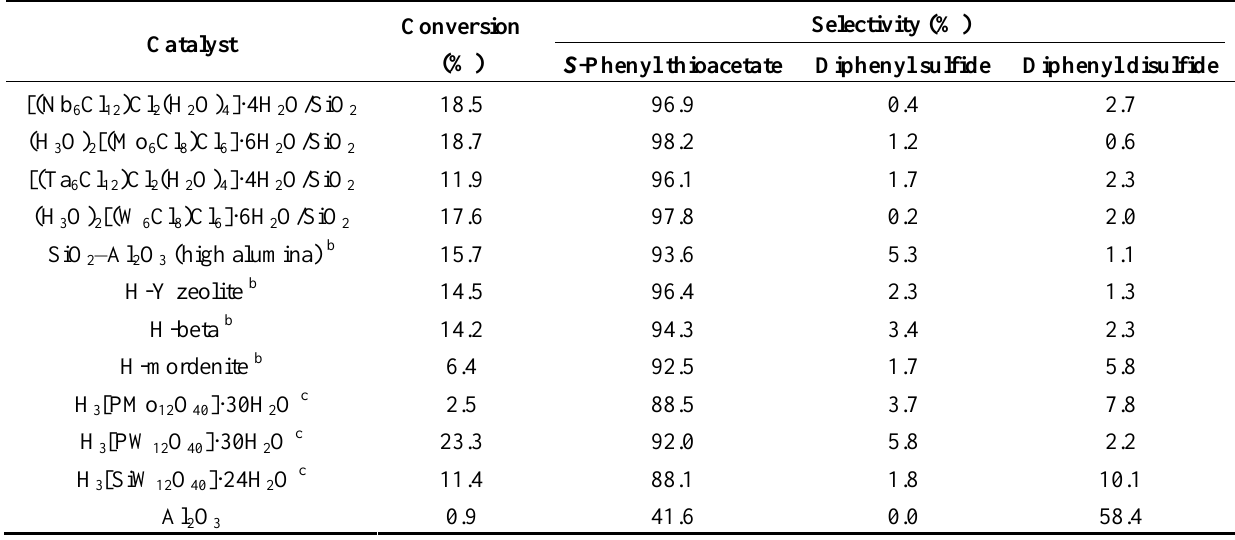
Table 10. S -Acetylation of benzenethiol with acetic acid over various catalysts a . Selectivity (%) Conversion Catalyst (%) S -Phenyl thioacetate Diphenyl sulfide Diphenyl disulfide